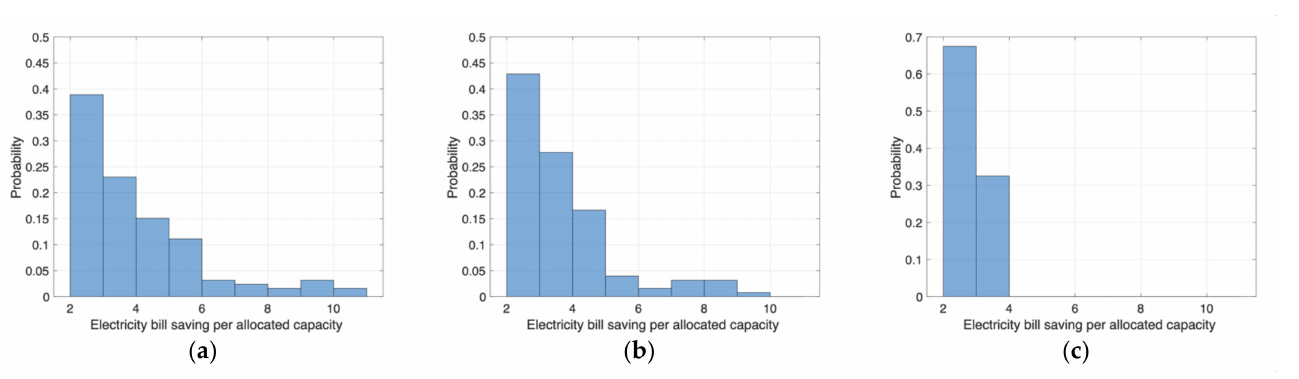
Figure 10. Distribution of the electricity bill savings per allocated capacity of each member when the community solar capacity is 100 kWp. ( a ) The P0 case. ( b ) The proposed strategy case. ( c ) The PP